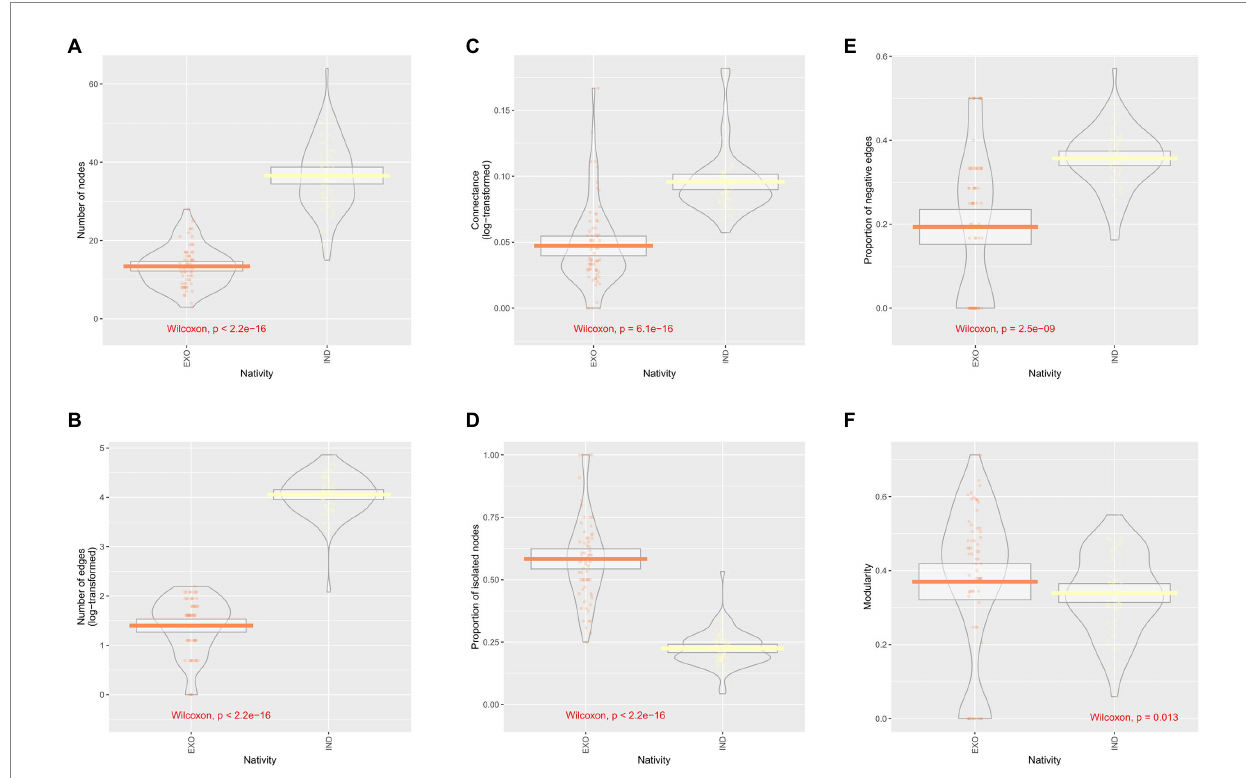
FIGURE 5 Comparison of network properties between indigenous-only and exotic-only networks: number of nodes in the network (A) , number of edges in the networks (B) , the log-transformed value of connectance (C) , the proportion of the isolated nodes (D) , the proportion of negative edges (E) , and the modularity based on the ‘edge betweenness’ community detection algorithm (F)